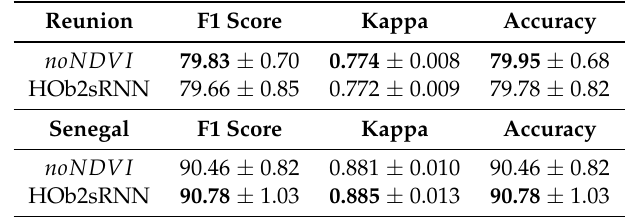
Table 9. F1 score, Kappa, and Accuracy when considering the exclusion of Normalized Difference Vegetation Index (NDVI) index on the study sites (results averaged over ten random splits). We have highlighted the best scores in